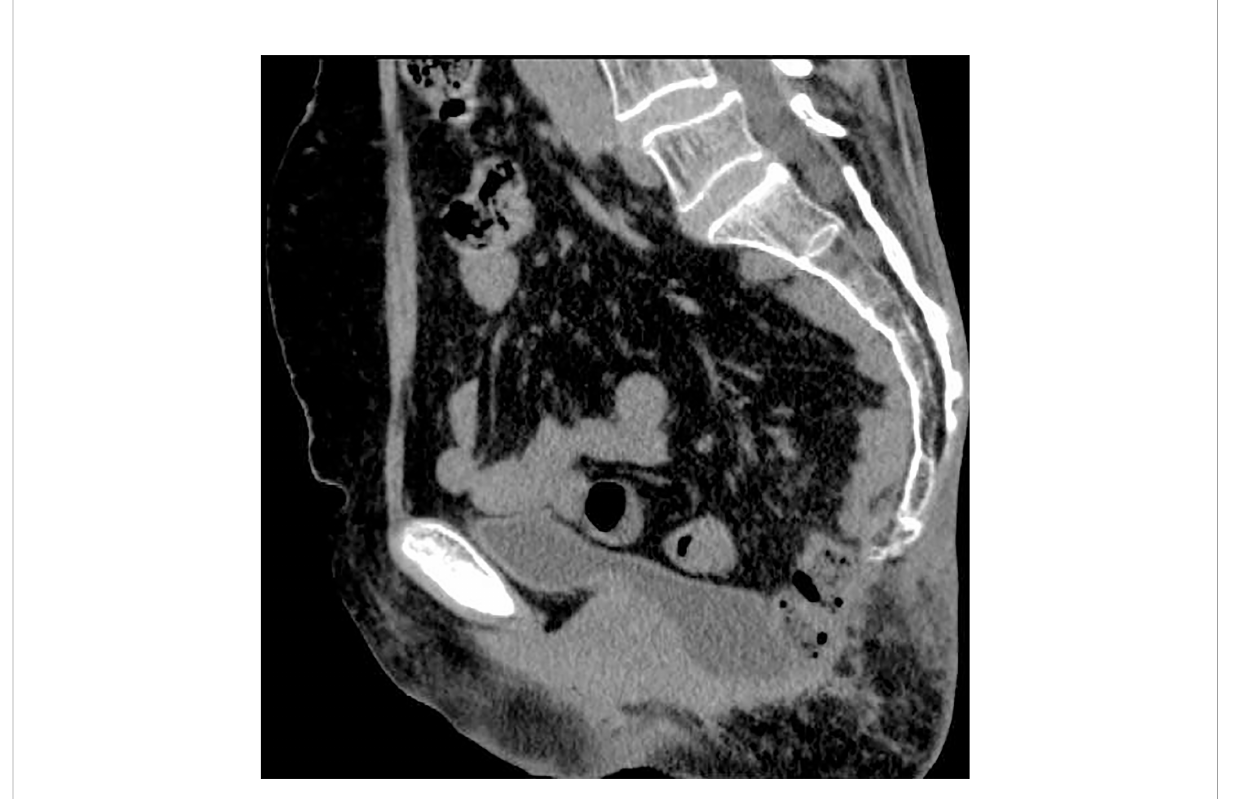
FIGURE 7 CT view of the hernia